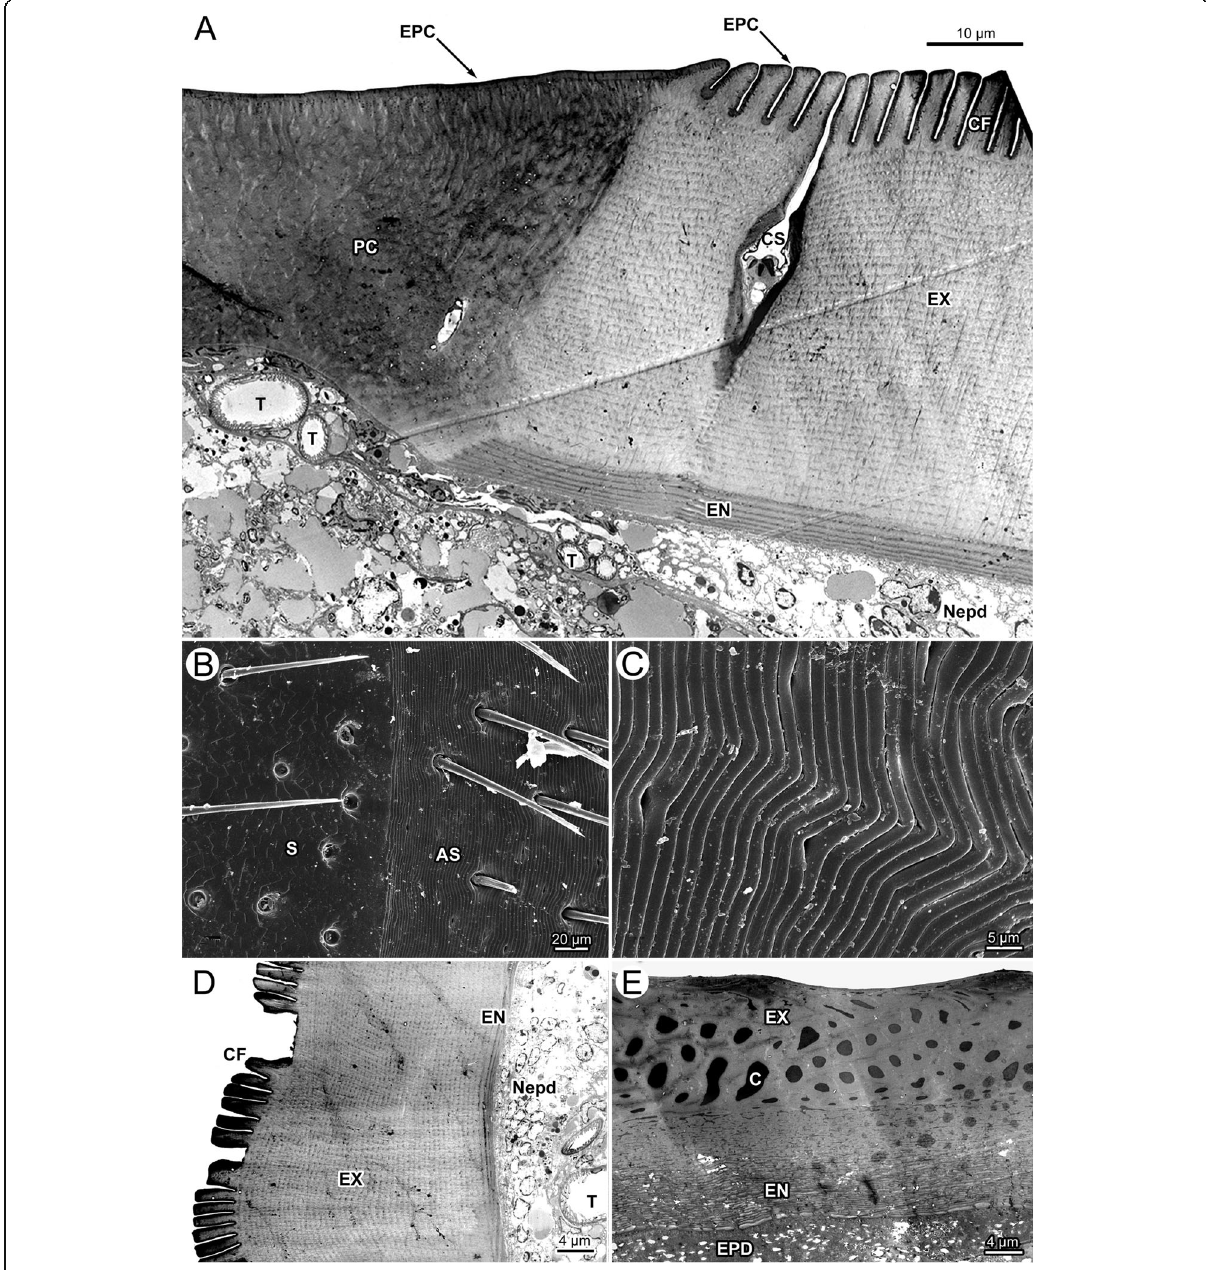
Fig. 4 Ixodes ricinus, electron microscopic micrographs of the cuticle. a TEM of the cuticle of a fasting female. The image shows the transition between scutum (left) and alloscutum (right). b SEM of the transition from scutum (left) to alloscutum (right) of a fasting female. c SEM of the cuticle of the alloscutum of a fasting female; close-up of the cuticular folds. d TEM of the alloscutum of a fasting female. e TEM of the cuticle of a fully engorged female. Abbreviations: AS, alloscutum; C, pore canal; CF, cuticular folds; CS, cuticular sensilla; EN, endocuticle; EPC, epicuticle; EPD, epidermis; EX, exocuticle; Nepd, nuclei of epidermal cells; PC, procuticle; S, scutum; T,